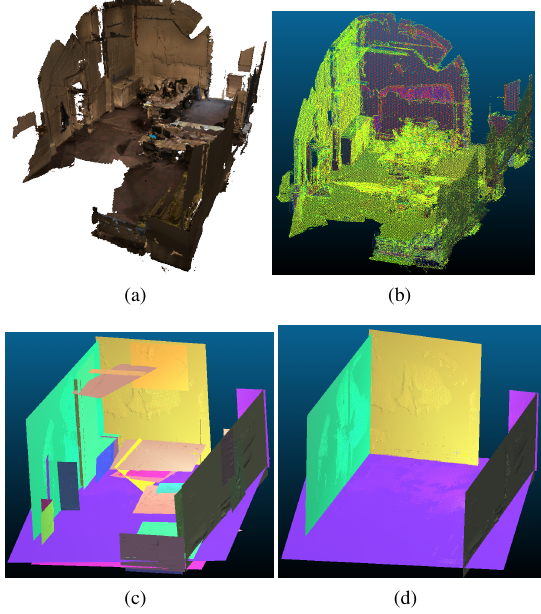
Figure 7: Planar patch detection using RANSAC. (a) 3D mesh provided by the Tango. (b) Equivalent point cloud. (c) Extracted patches. (d) Patches corresponding to walls and fl